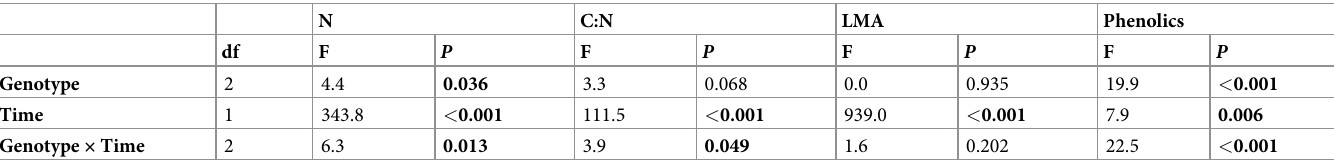
Table 3. F and P values of two-way ANOVA examining the effect of compatible HF genotypes (Genotype: H13-US, H13-ISR), time of infestation (Time: Four and twelve days post infestation), and their interaction on relative changes, compared with pre-infestation averages, in nitrogen (N), ratio of carbon to nitrogen (C:N), leaf mass per area (LMA) and phenolics.